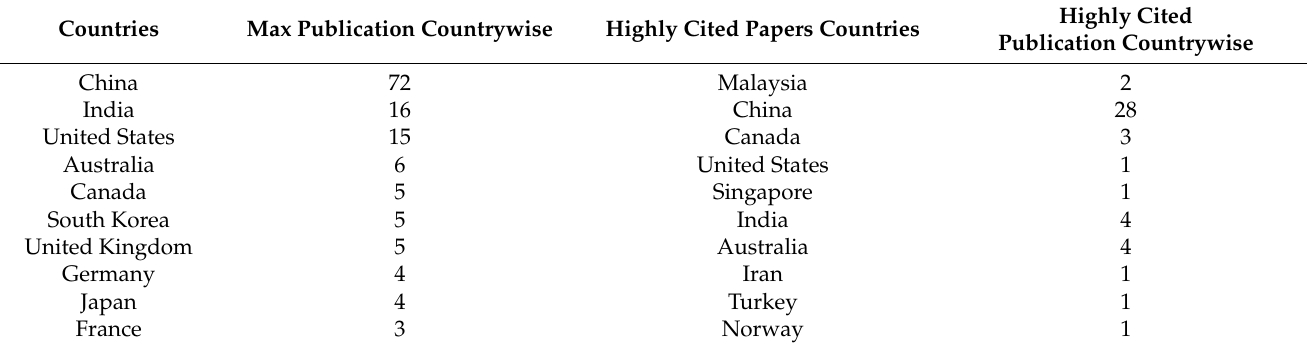
Table 5. Comparison of top ten countries in all and highly cited paper countries.